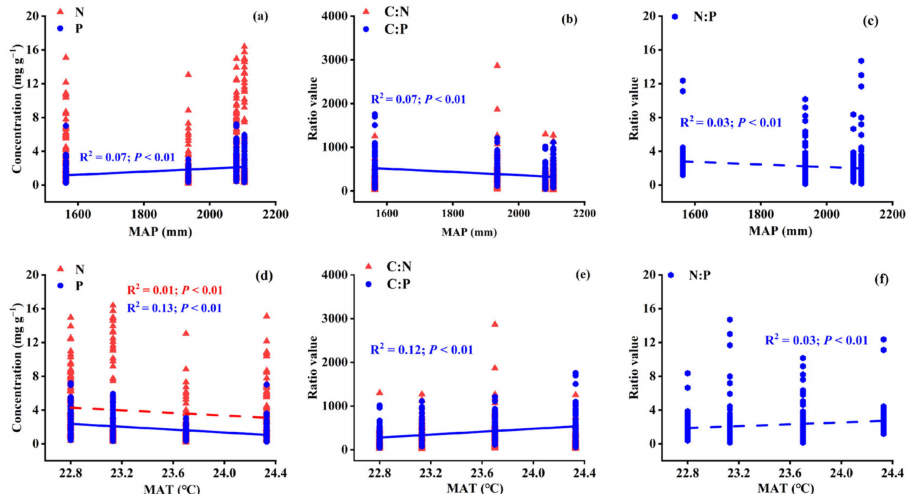
Figure 4. Correlation between leaf stoichiometry and climatic factors. Both the red dotted and blue solid lines represent significant correlations between leaf stoichiometry and climatic factors ( p < 0.05, p < 0.01). No line indicates the absence of a significant correlation between leaf stoichiometry and climatic factors. MAP and MAT represent the mean annual precipitation and temperature,